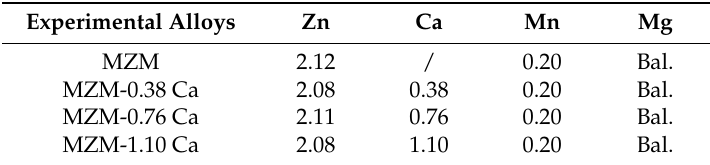
Table 1. Chemical composition of the experimental alloys (wt